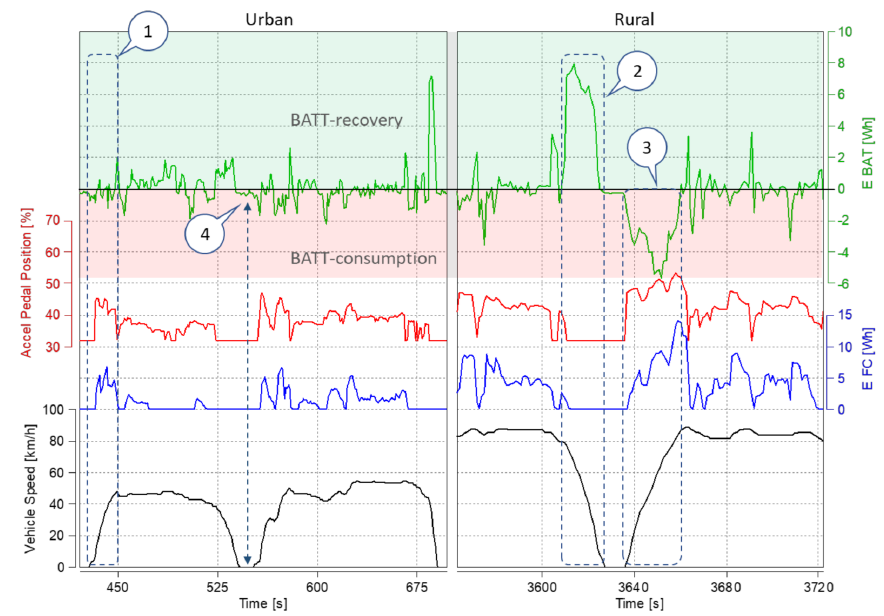
Figure 10. Interaction of powertrain components during driving of Toyota Mirai (selected events on